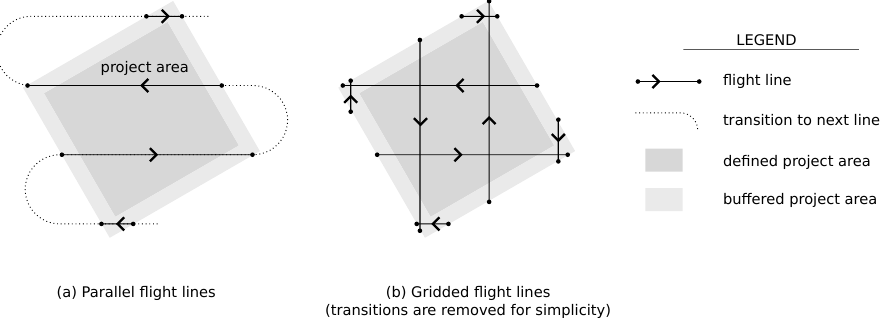
Figure 1. Comparison of the conventional parallel flight line approach and the gridded flight line approach optimized for mapping dense urban